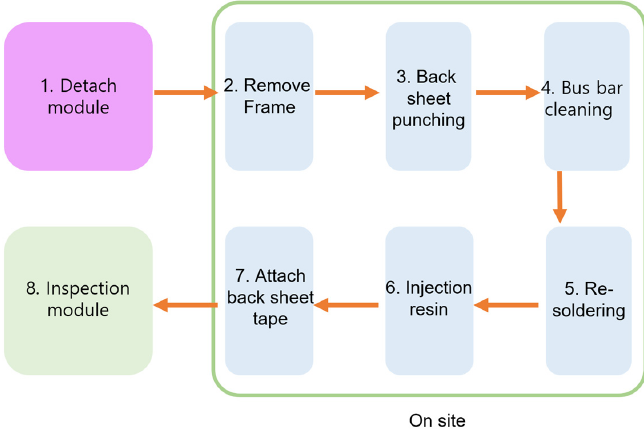
Figure 15. On-site recovery process for RSB hotspot PV module. Table 7. Long-term reliability assessment after TC 200 test.